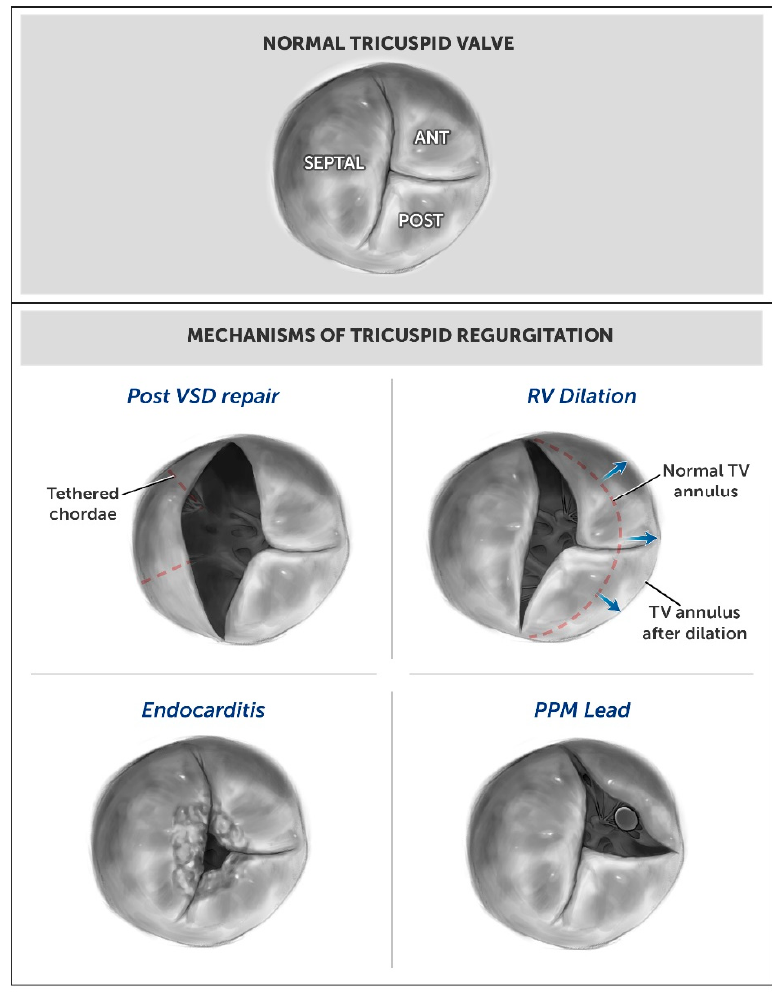
Figure 1. Mechanisms of Tricuspid Regurgitation in Patients with Repaired Tetralogy of Fallot. (ANT–anterior, POST–posterior, VSD–ventricular septal defect, RV–right ventricle, TV–tricuspid valve, PPM–permanent pacemaker).